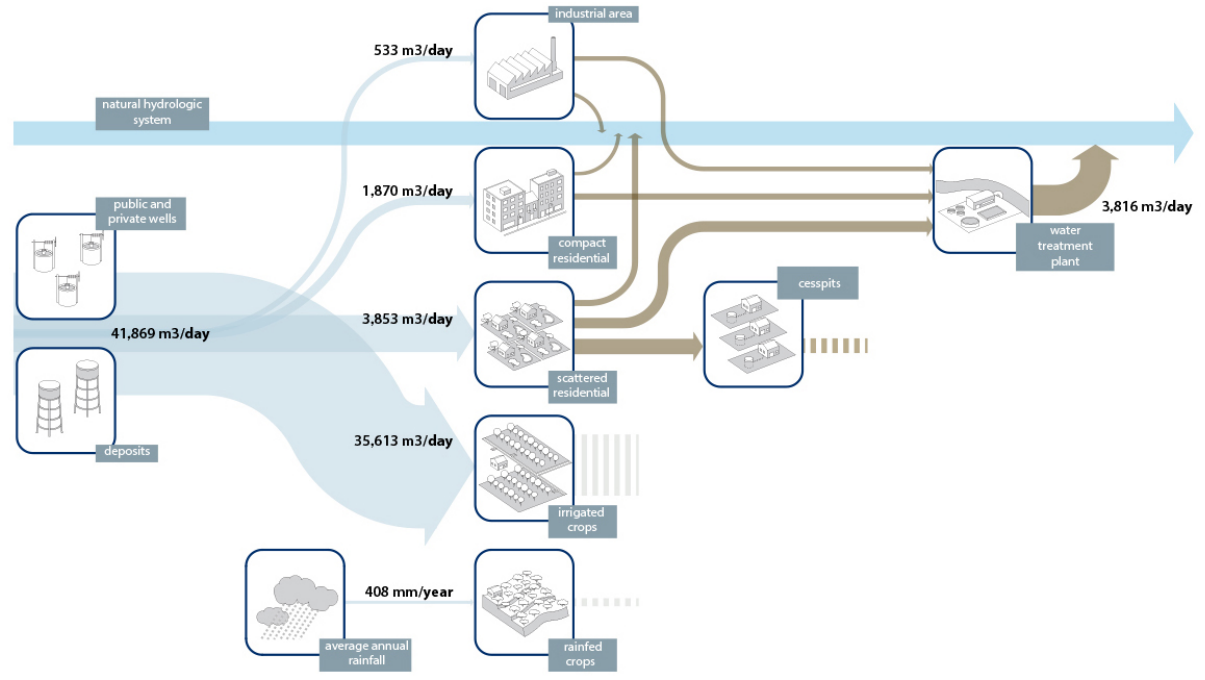
Figure 4. Main water flows in the SCSP. Source: Galan